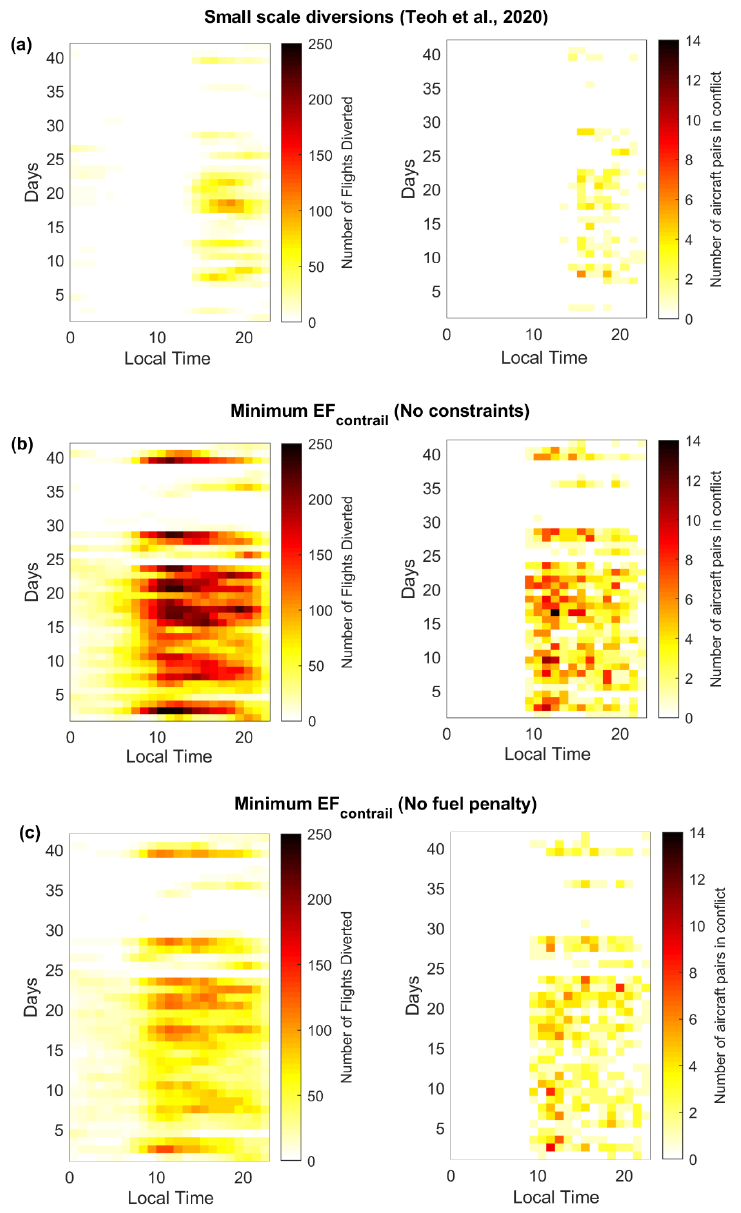
Figure 3. Daily variations in the number of flights diverted (left) and ATM conflicts (right) at different times of the day for: ( a ) the small-scale diversion strategy proposed by Teoh et al. [28]; ( b ) the minimum EF contrail strategy with no constraints (Section 3.1.3); and ( c ) the minimum EF contrail strategy with fuel penalty constraints (Section 3.1.4). The CARATS Open Data consists of 42 days of air traffic data, and each row represents the results for one day.